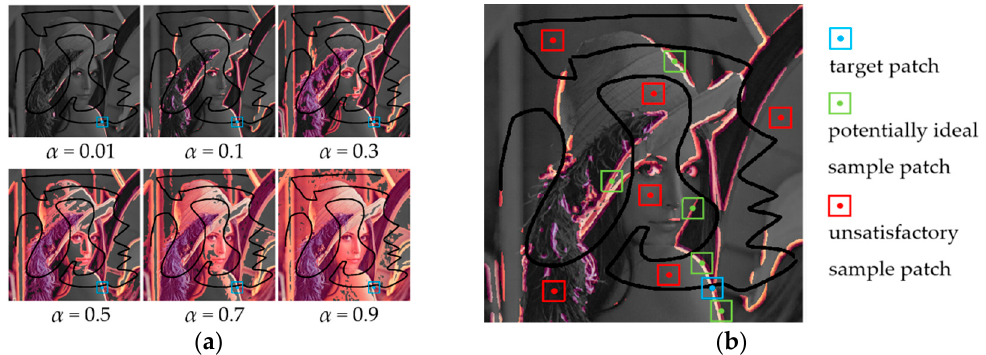
Figure 4. ( a ) Effect of parameter 𝛼 on the subregion for search (colored area); ( b ) illustration for 275 Figure 4. ( a ) E ff ect of parameter α on the subregion for search (colored area); ( b ) illustration for searching the ideal sample patches within the subregion ( 𝛼 (cid:3404) 0.1 ). 276 searching the ideal sample patches within the subregion ( α =